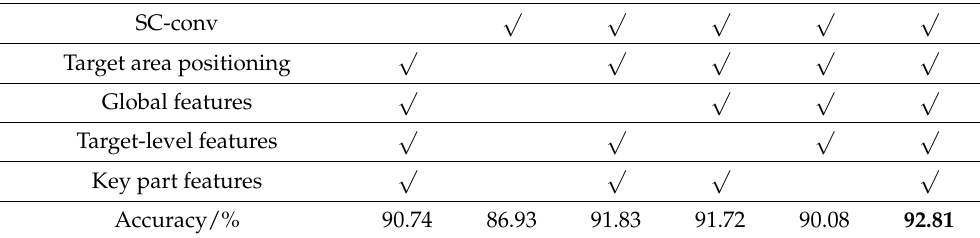
Table 5. Comparison of classification performance of different modules. Bold values indicate best